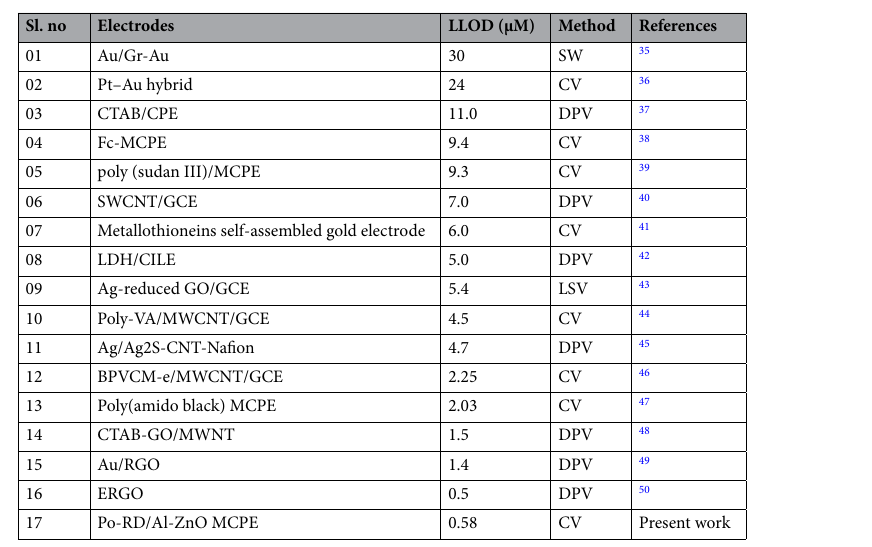
Table 4. Comparative analytical performance electrode for